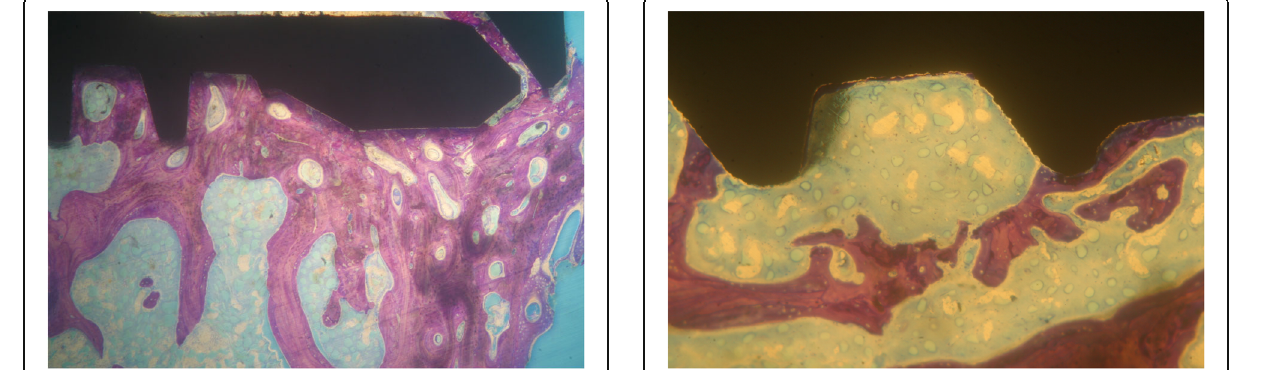
Figure 3 Test group. The present histological photo showed a continuous thin layer of newly formed bone along the neck area of the implant (magnification × 25 — toluidine blue)